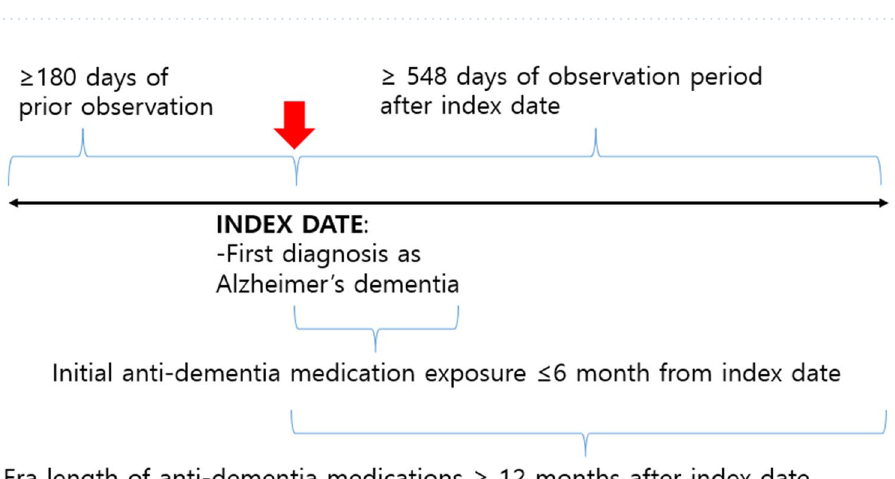
Figure 1. Event flow of treatment pathway. The index date for each case was the time of the first diagnosis as Alzheimer’s dementia. The patient had to have been observed for at least 180 days before and 548 days after